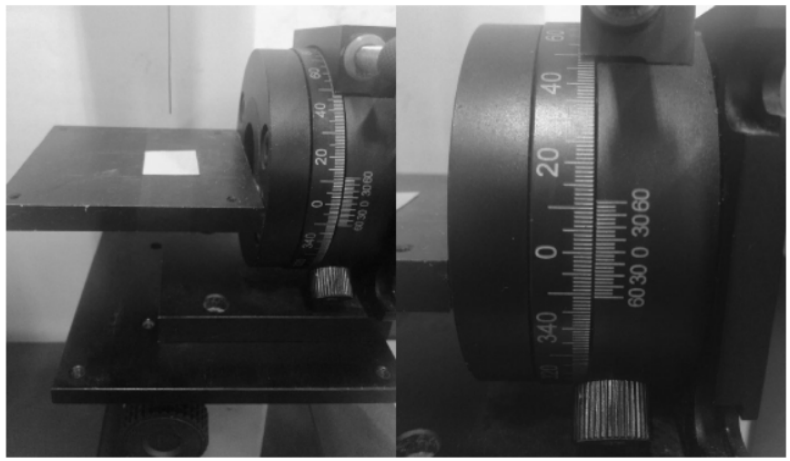
Figure 3. Test rotary table for rolling angle. The measurement for wear resistance of the sample was performed by sanding the sample with a 220-mesh sandpaper, as shown in Figure 4. The relative speed was 5 cm s − 1 , while the pressure was 1000 Pa. The contact and rolling angles were recorded after sanding every five